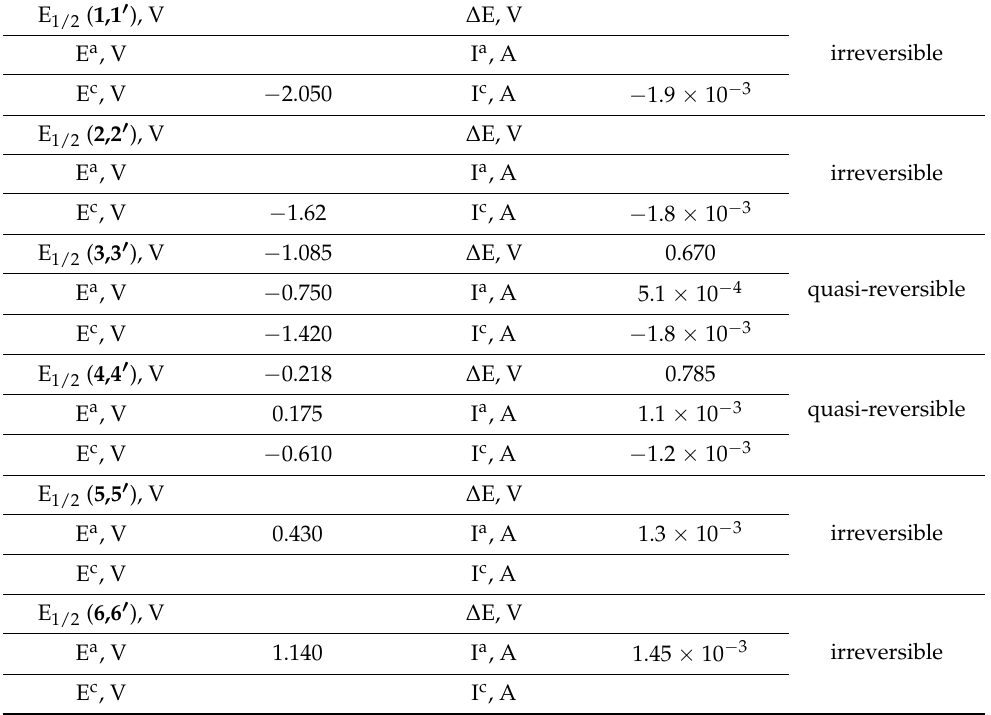
Table 3. Characteristics of half-wave potentials, as well as anodic and cathodic current peaks of the (Bu 4 N) 4 [Mo 8 O 26 ]